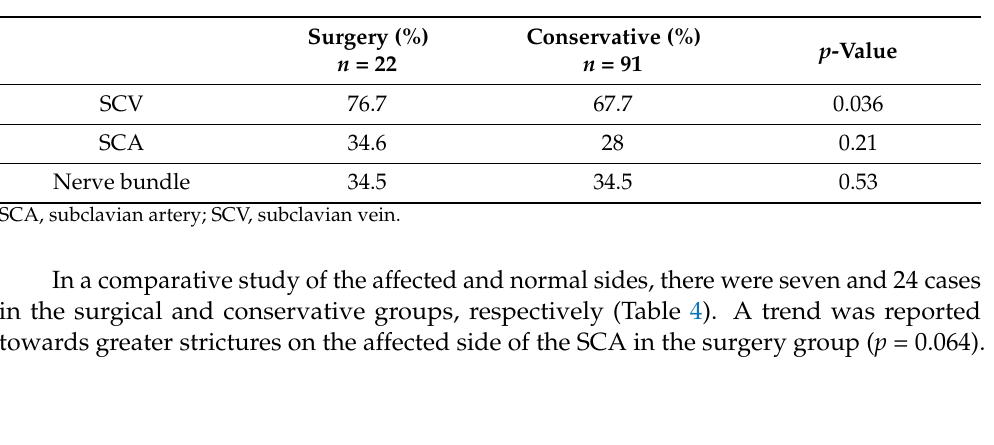
Table 3. Stenosis rates of SCV, SCA, and nerve